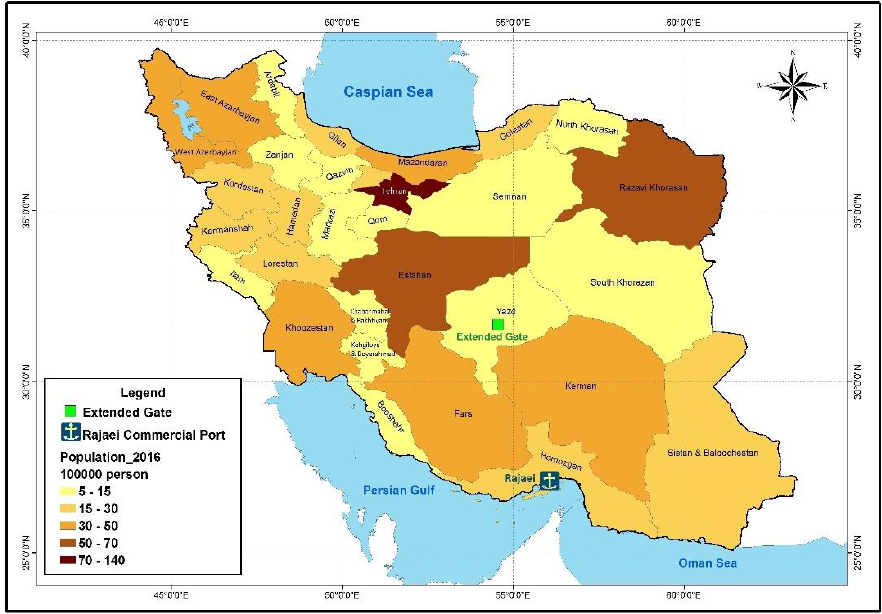
Figure 2. Population distribution in Iran’s